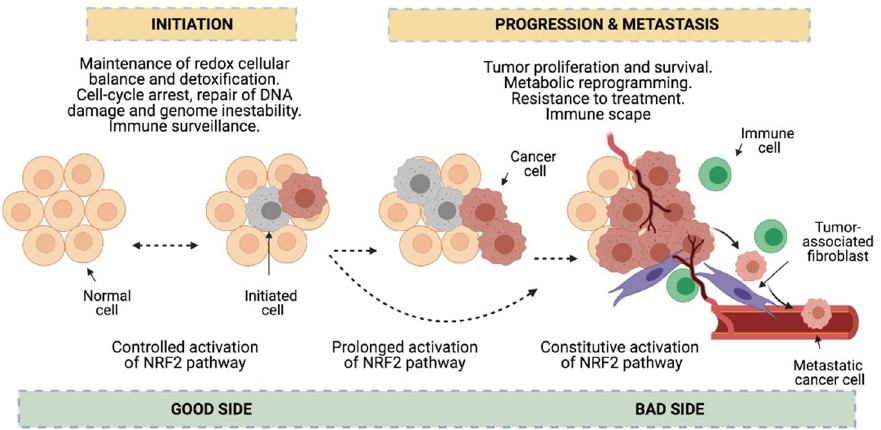
Figure 4. Dual role of NRF2 in cancer. NRF2 functions seem to be beneficial or prejudicial for tumorigenesis depending on the cancer stage. In early stages, NRF2 is protective in premalignant carcinogenesis and maintains redox cellular balance which assists in the detoxification process, DNA damage, cell-arrest, genome instability and immune surveillance (good side of NRF2 against cancer). However, prolonged or constitutive activation of NRF2 contributes to cancer progression and metastasis, since NRF2 favors tumor proliferation and survival, metabolic reprogramming, resistance to treatment and immune escape (bad side of NRF2).